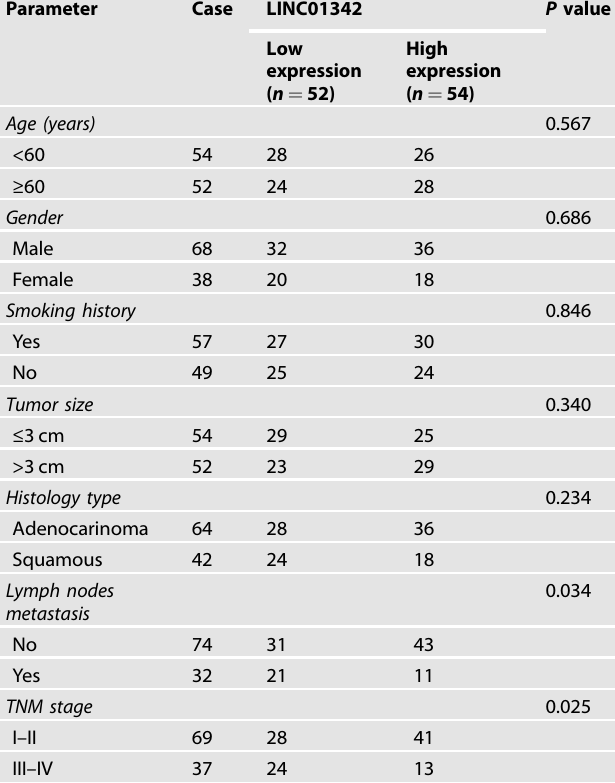
The enumeration data were analyzed using the chi-square test. TNM